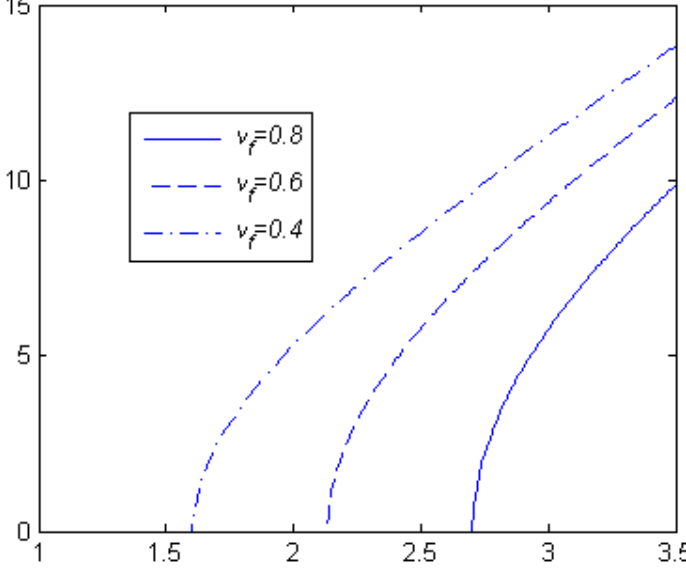
Figure 4. The first supercritical natural frequencies for a pinned–pinned case. After analyzing nature frequencies, the nonlinear vibration Equation (17) is